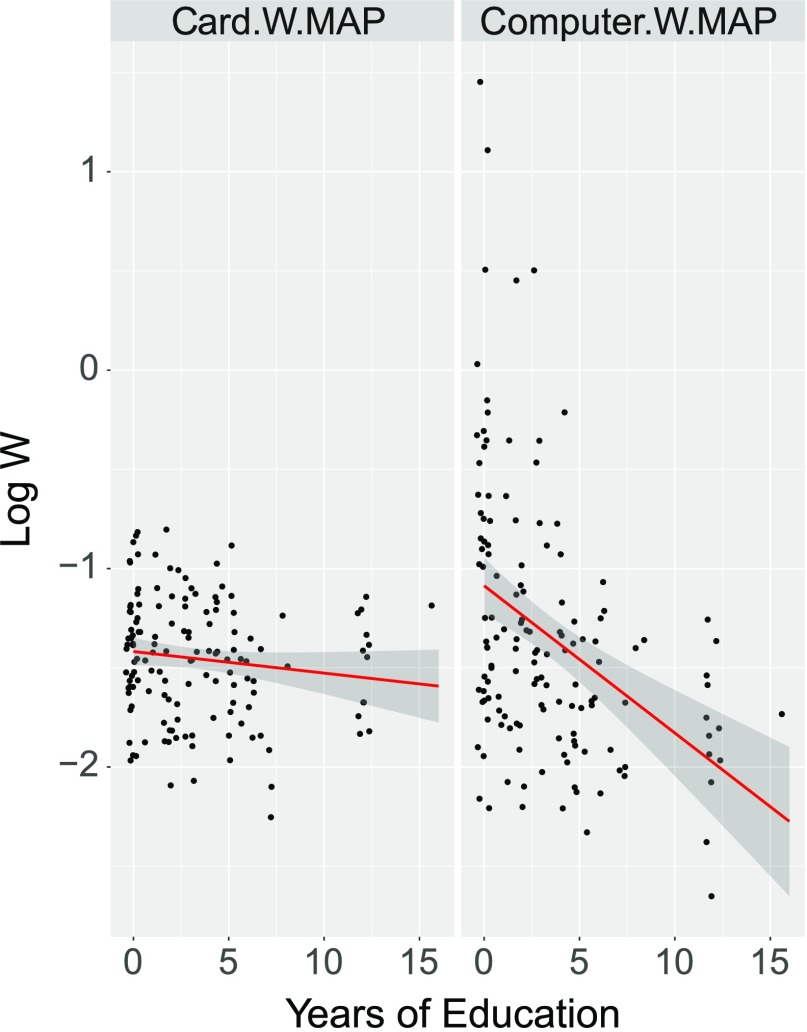
Plot of the relationship between years of Tsimane’ education and Log(W) for the two versions of the task: Cards vs. Computer. As shown in Table 1, there is a reliable interaction between Tsimane’ education and task, such that there is a strong correlation between education and Log W for the computer version of the task on the right, but nothing reliable in the card version on the left (see Table 2).4